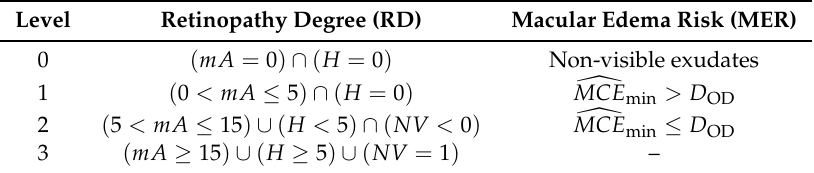
Specific constraints to evaluate the Retinopathy Degree (RD) and Macular Edema Risk (MER), by employing the ocurrence frequency of microaneurysms ( mA ), hemorrhages ( H ), and neovascularization ( NV ), as well as the MaCula to Exudate distance ( disk diameter ( D OD ) [25].